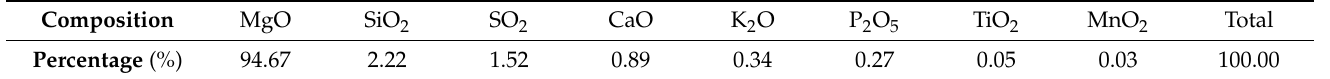
Table 2. The chemical composition of magnesium